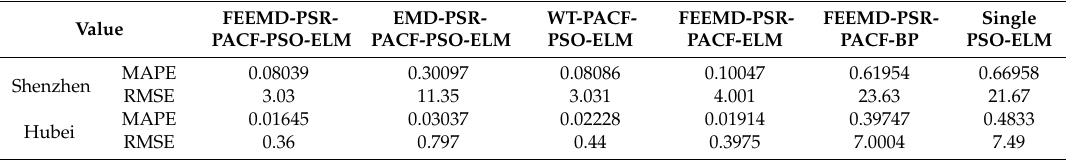
Table 9. A comparison of the different forecasting models under the Shenzhen ETS and the Hubei ETS.